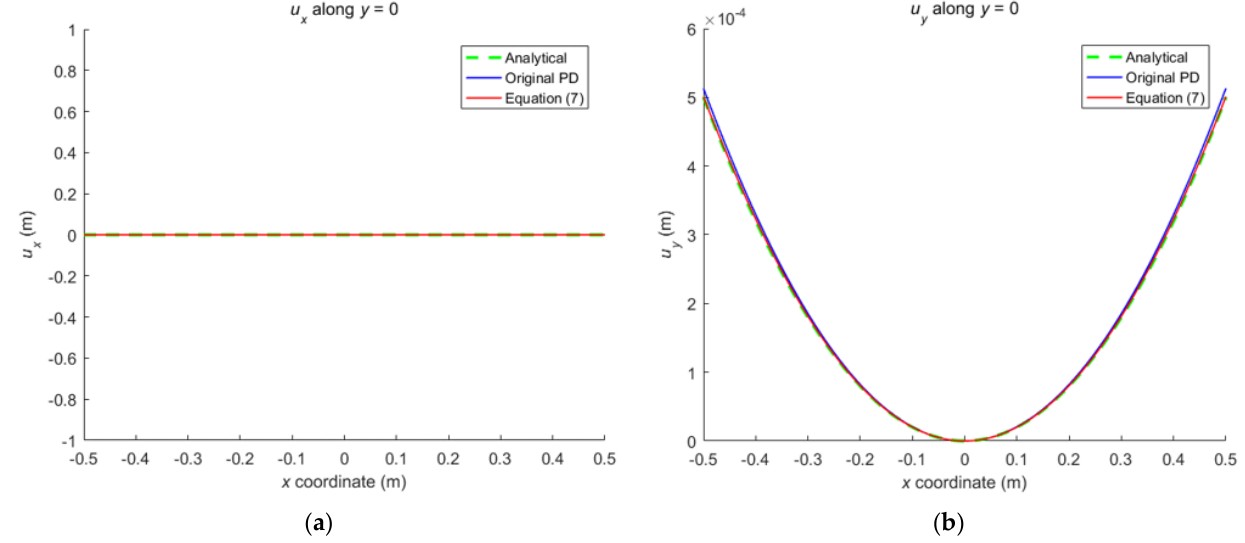
Figure 15. The displacement along the horizontal line y = 0 when the plate bending: ( a ) u x along y = 0; ( b ) u y along y = 0.